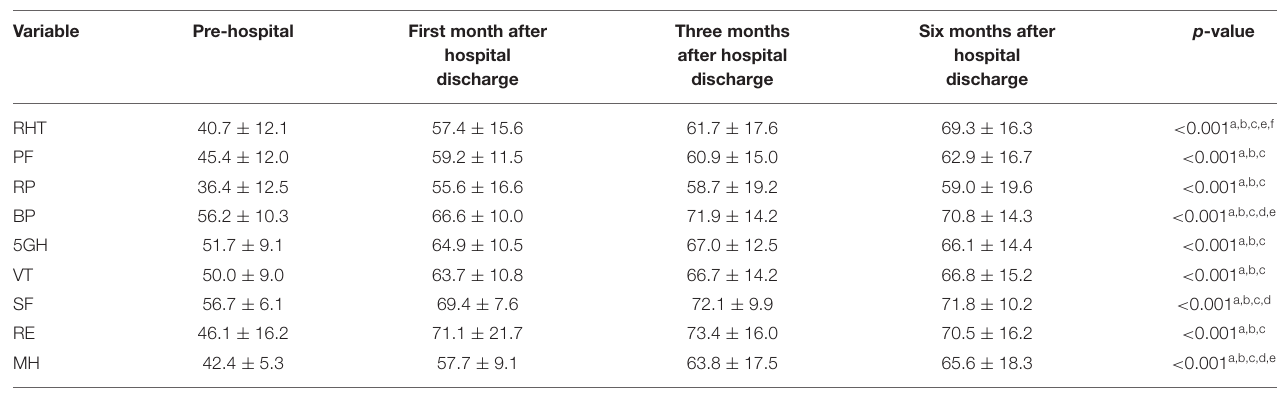
TABLE 5 | HEN quality of life